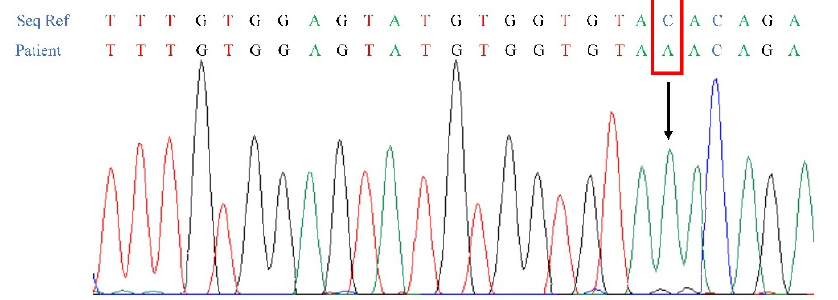
Figure 4. Electrophoregrams showing the identified p.Tyr414* (c.1242C>A) variant in XYLT2 (NM_022167.3), in the affected patient